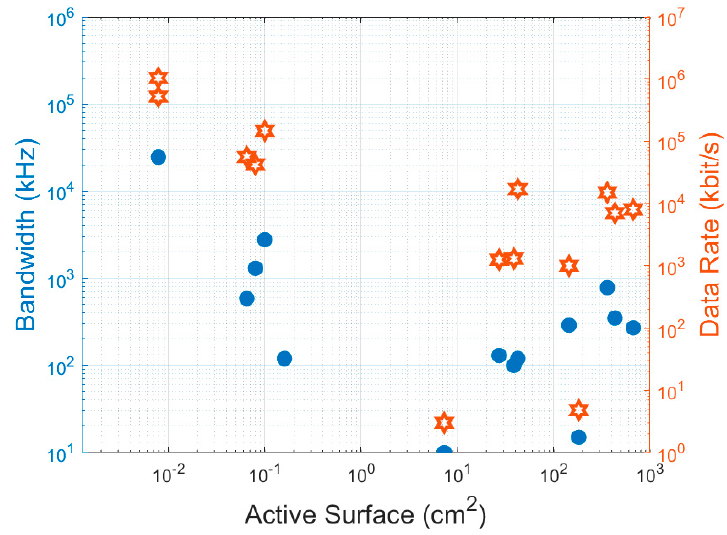
Figure 7. Measured bandwidth and data rate for PV devices with different active surfaces. Data obtained from references [61,62,64,71,75,78,83–85,87,91,99,100,107,109].